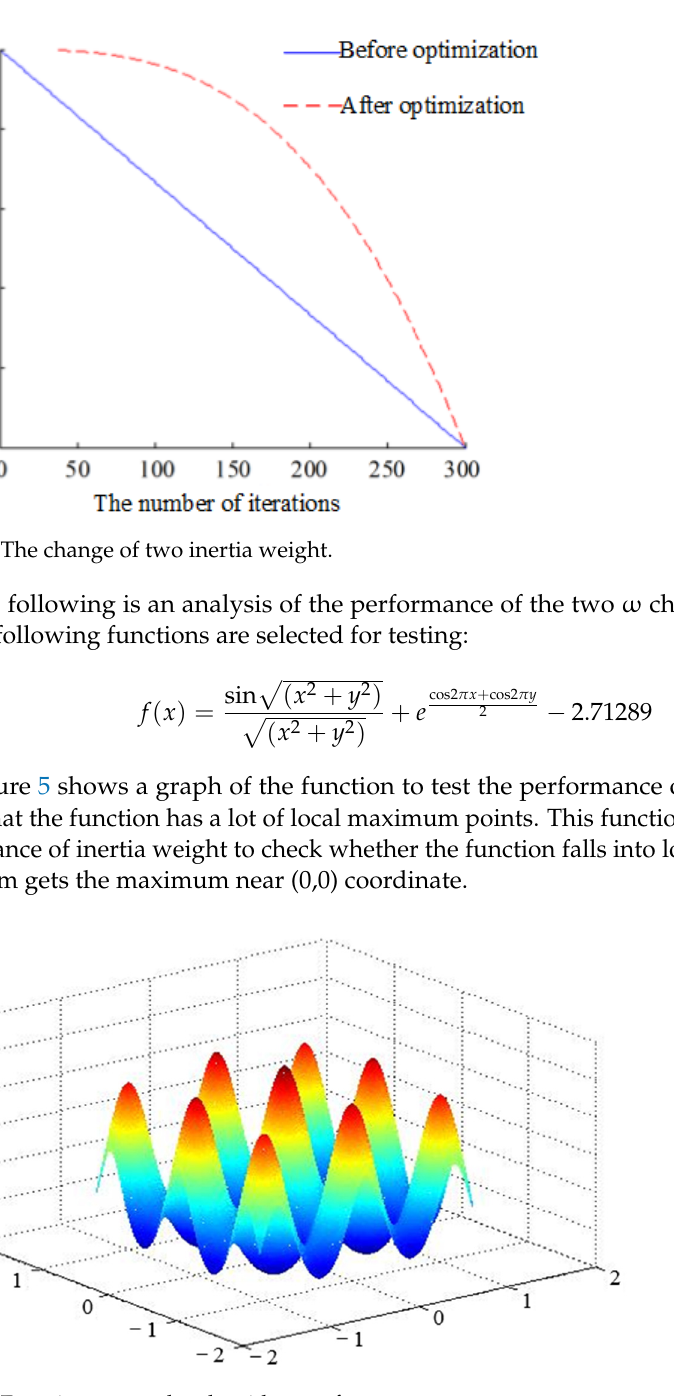
Figure 5. Function to test the algorithm performance. The algorithm parameter is set to population size of 20 and evolution of 300 genera- tions. The experiment is set up to run for 100 times, and the average of 100 times is taken as the final result. The two inertia weights are solved, and the average value, failure times and near-optimal times of the solutions are compared to analyze the convergence accu- racy, convergence speed and other performances.